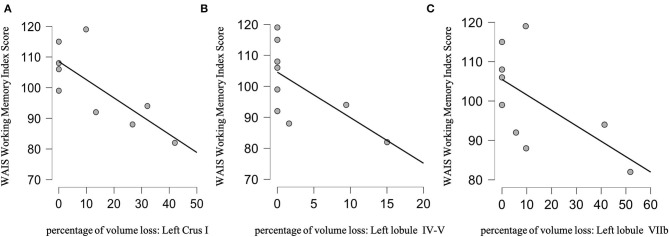
Scatter plots of the significant correlation analysis between the WAIS Working Memory Index Score and the percentage of brain volume loss of cerebellar left Crus I (A), left lobule IV-V (B), and left lobule VIIb (C).